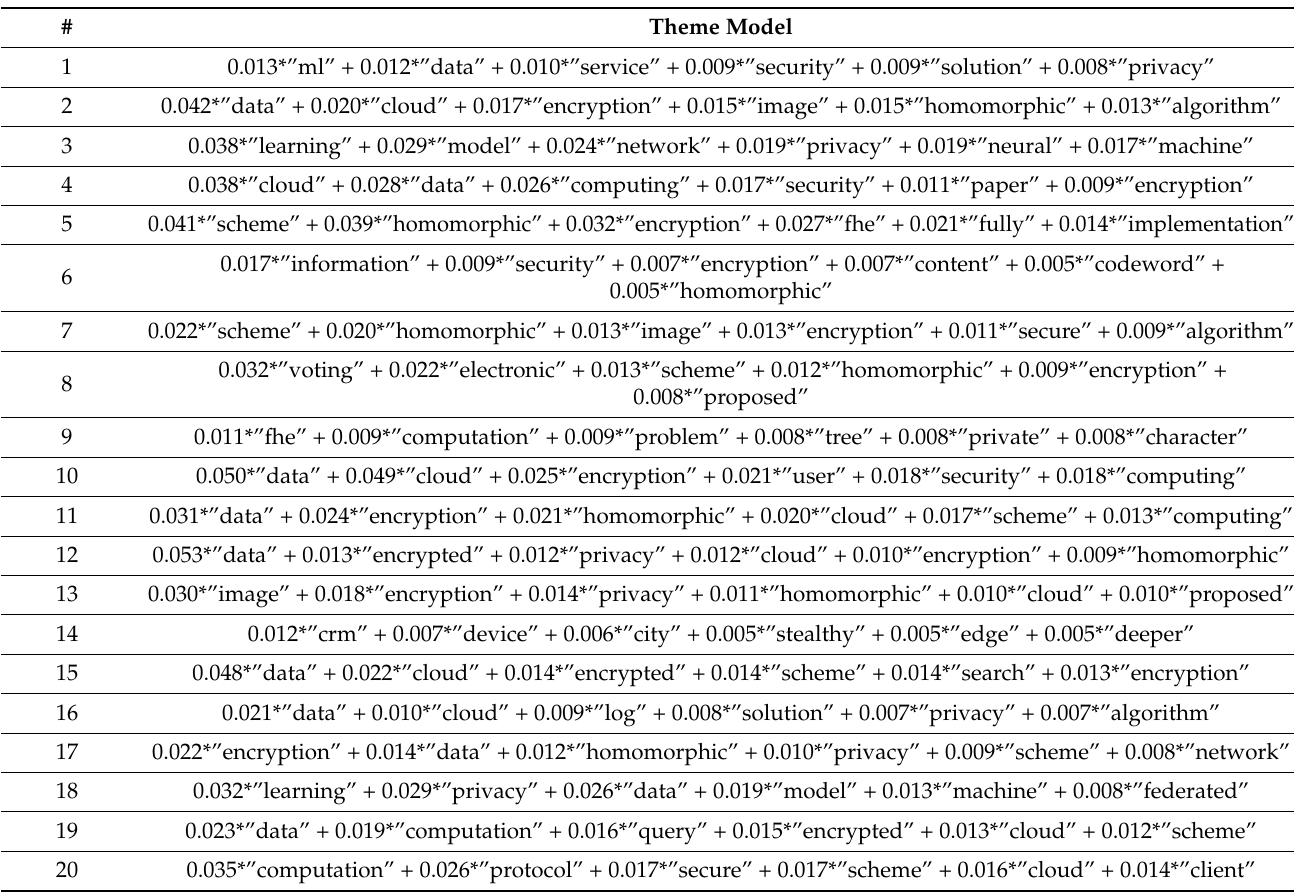
Table 9. LDA Topic Modeling in